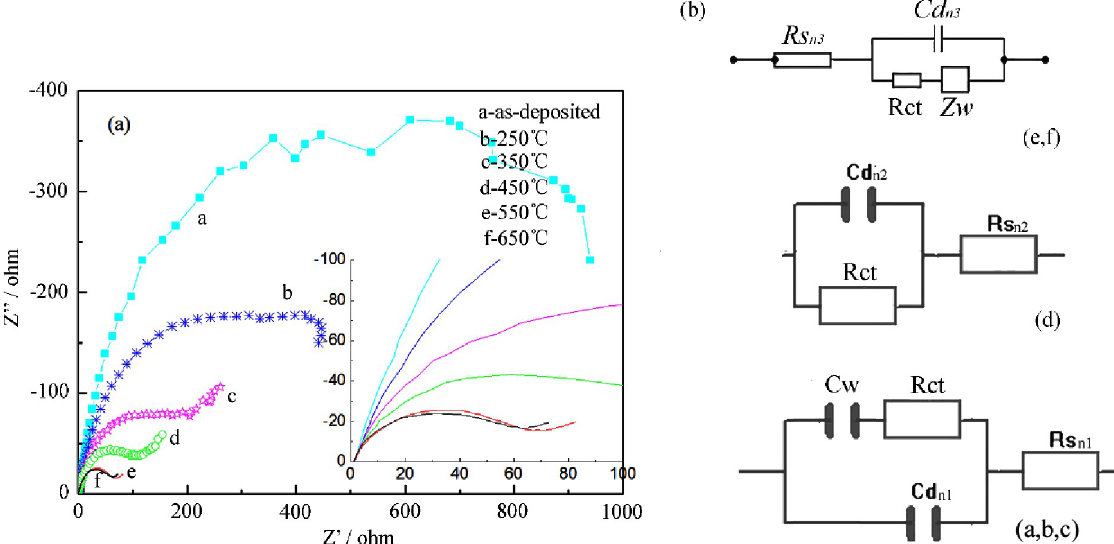
Fig 6. Electrochemical impedance spectroscopy for as-deposited and heat-treated samples (a) and equivalent circuit (b).